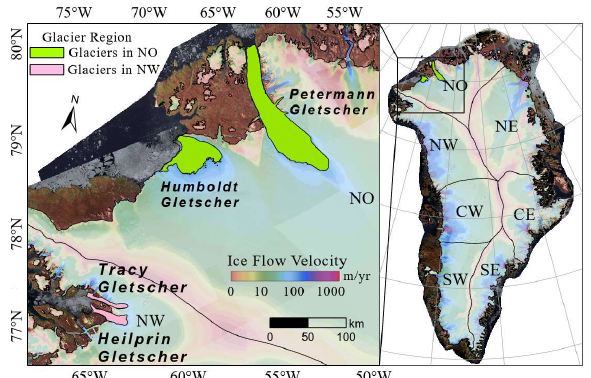
Figure 3 . The locations of the Humbolt glacier, Petermann glacier, Tracy glacier and Heilprin glacier. The background is a scale are better than those at image scale. Figure 7 shows Landsat Image Mosaic of Greenland (Chen et al., 2020). The ice flow velocity product displayed here is from MEaSUREs Multi- year Greenland Ice Sheet Velocity Mosaic, Version 1 (Joughin et al., 2016).